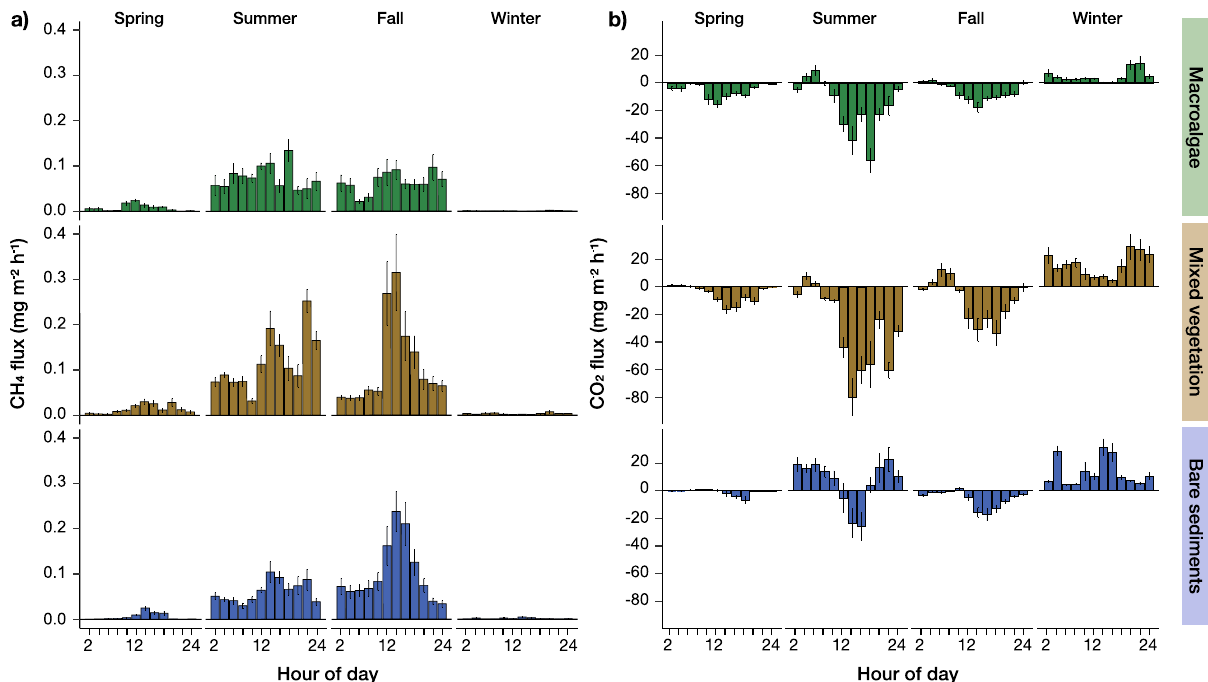
Fig.1|Hourlymethaneandcarbondioxidesea-air fl uxesincoastalmacroalgae, mixedvegetation,andbaresedimenthabitats. Hourlysea-airCH 4 ( a )andCO 2 ( b ) fl uxes across four seasons in three coastal ecosystems. Values are means ± standard error. Positive fl uxes refer to an ef fl ux from the water to the atmosphere (source),